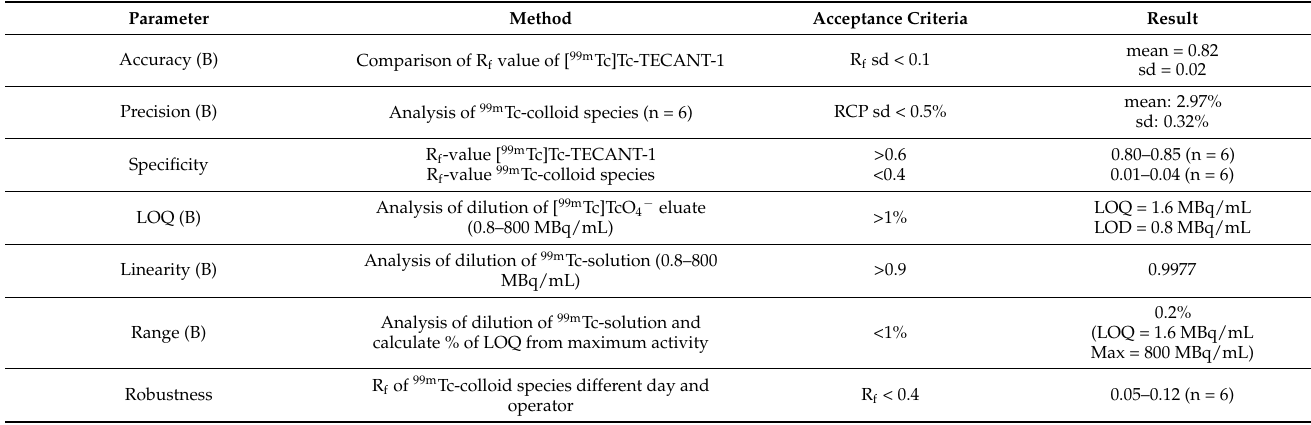
Table 2. Summary table of validation parameters, acceptance criteria and results for iTLC method for determination of the percentage of 99m Tc-colloidal species